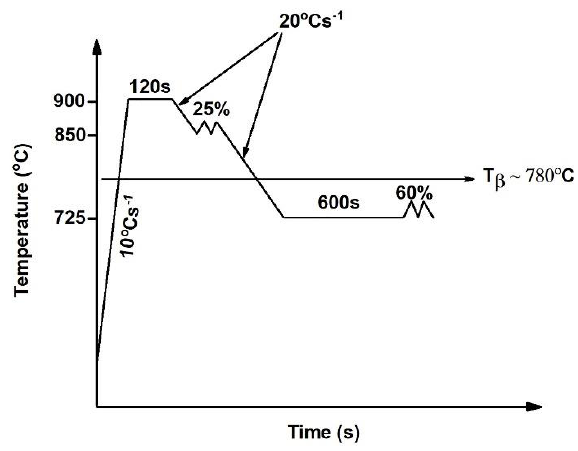
Figure 1. A schematic diagram of the thermo-mechanical processing used in this